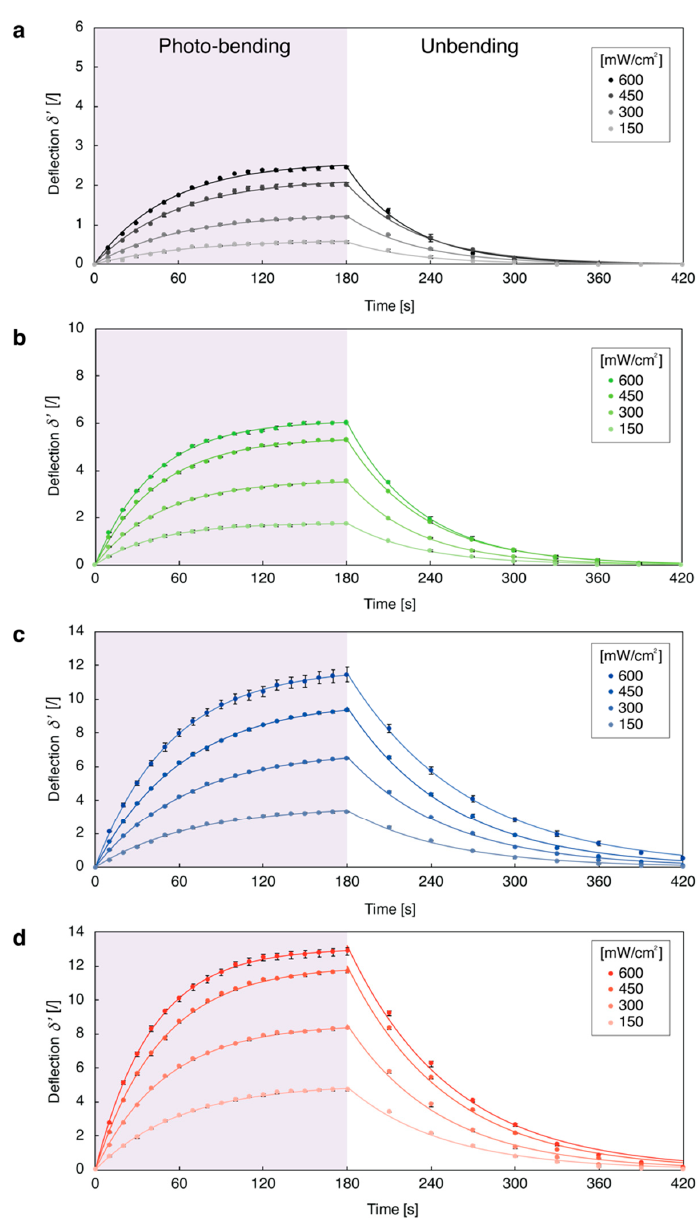
Figure 3 . Time dependence of deflection δ ’ of hybrid silicones under UV light illumination at different light intensities and after stopping the irradiation. Panels show the results of hybrid silicones of ( a ) 0, ( b ) 1, ( c ) 5, and ( d ) 10 wt%. Plots drawn by small circle indicate the average value of deflection repeatedly observed three times, with standard deviations. Solid lines are the results of fitting to exponential models for photo-bending and unbending processes. Table 3. Summary of A and τ b obtained by fitting to the exponential model for photo-bending. Light (mW/cm 2 )